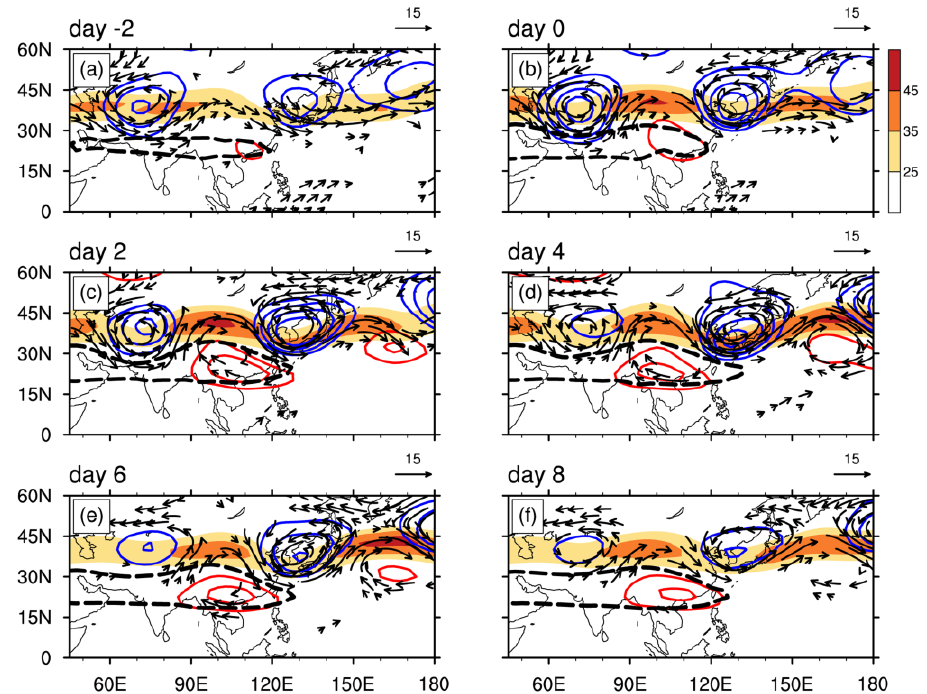
Figure 4. Composite 200 hPa horizontal wind anomalies (vector, units: m s −1 ), normalized height anomalies (contours are ±0.5, ±1.0, ±1.5, ±2.0 standard deviation, blue for negative and red for positive) and zonal wind speed (shading, units: m s −1 ) in EAP/SR-C events from day −2 to day 8 with interval of 2 days ( a – f ). The thick dashed lines (1250 dagpm-contour) portray the activities of the SAH at 200 hPa.